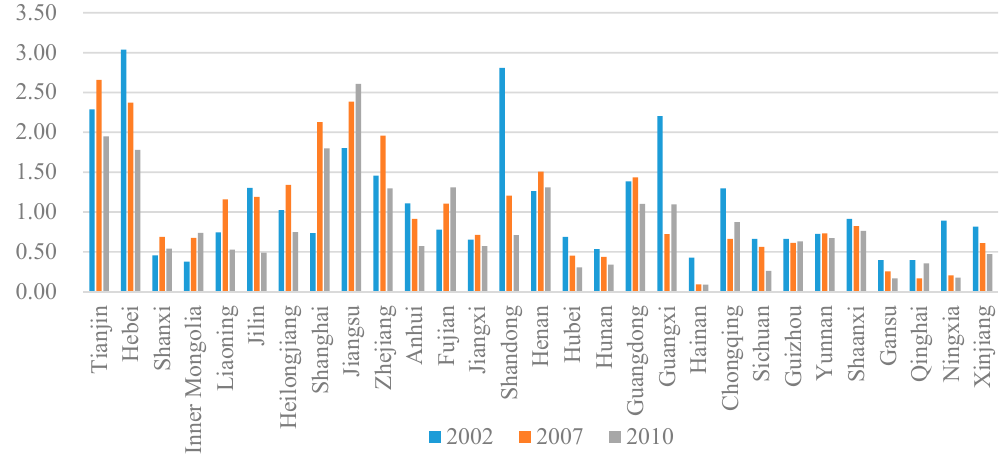
Figure 2. Embodied carbon flowed out from Beijing to other provinces in 2002, 2007, and 2010 (million tons).